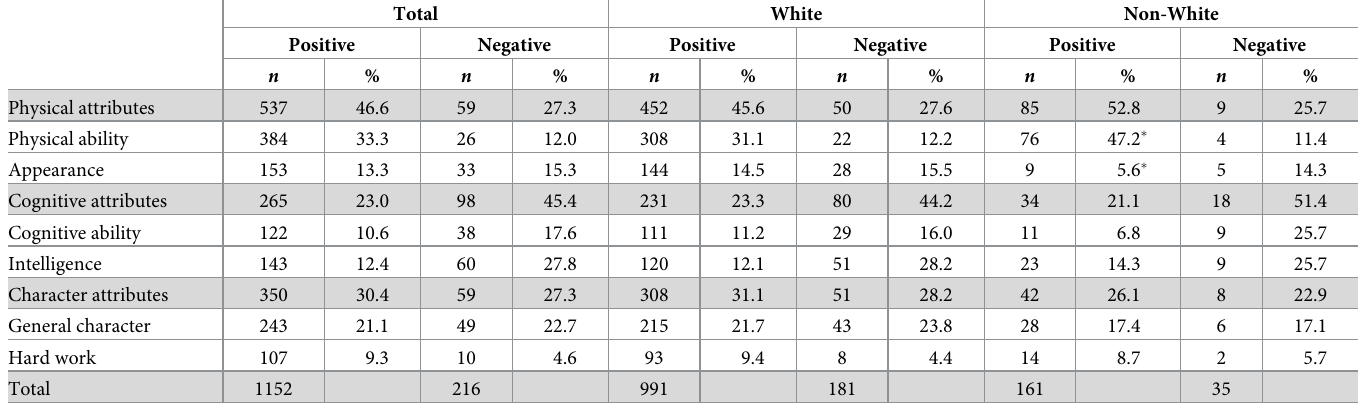
Table 3. Proportion of positive and negative statements by race for each main attribute category and subcategory.